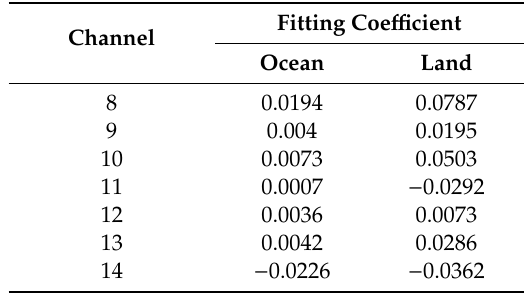
Table 3. Fitting coefficient between biases and satellite zenith angles for all channels over the ocean and land.